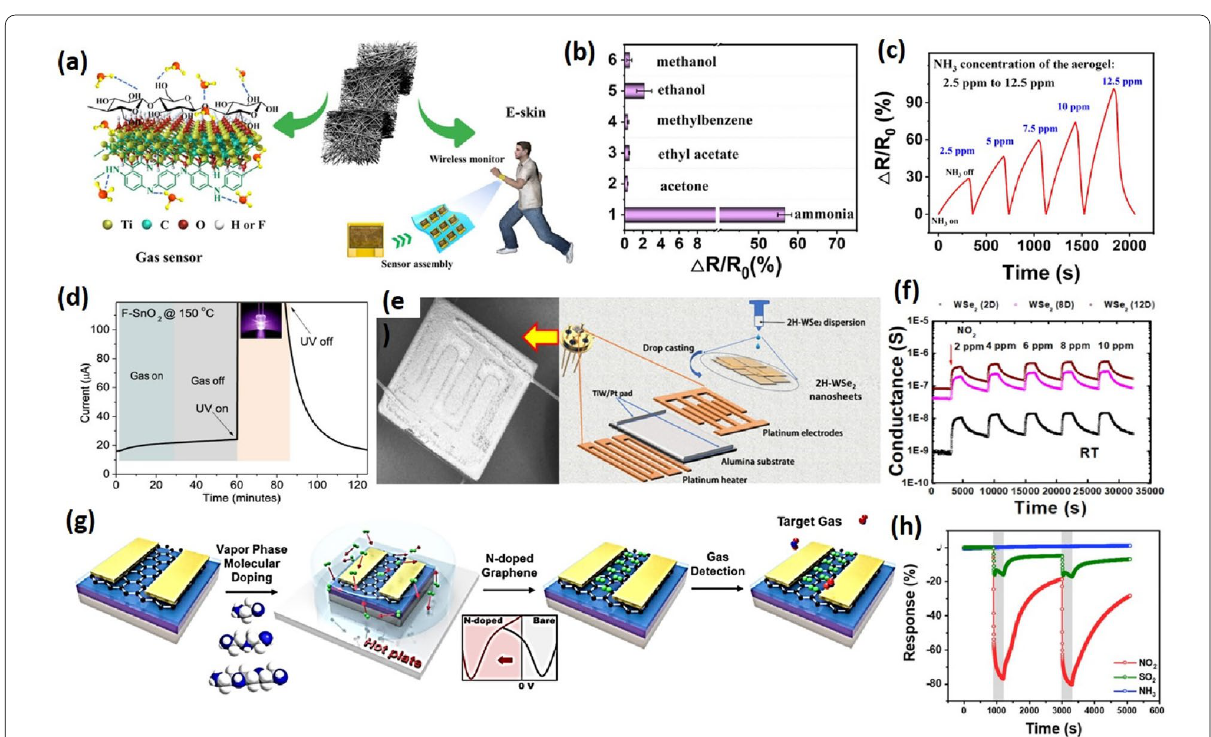
Fig. 6 a Components of the MXene/PANI/BC aerogel and the schematic of the MXene/PANI/BC aerogel for the applications of e-skins and gas sensors. b Selectivity. c Response of the Ti 3 C 2 T x MXene/PANI/BC composite aerogel-based gas sensor to NH 3 gas for varied concentration ranges. [98] d Sensor current response profile with the UV-on of F-SnO 2 sensor [101] e fabrication process and design of the 2H-WSe 2 nanosheet sensor. f Dynamic response of 2H-WSe 2 (2D), 2H-WSe 2 (8D), and 2H-WSe 2 (12D) sensors at RT. Figure adapted from ref [109] g Schematic illustration of the fabrication process of a FET gas sensor based on n-doped graphene h Gas sensing characteristics of DETA-doped graphene